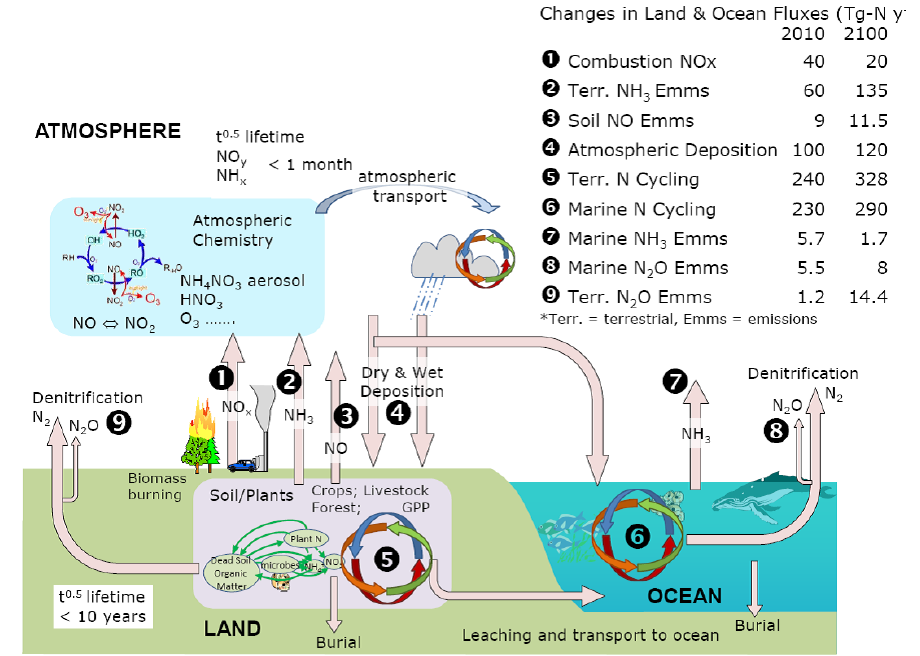
Figure 15. Changes in the major fluxes and in the terrestrial, marine and atmospheric processing of reactive nitrogen (N r ) between 2010 and 2100, adapted from Fowler et al.,